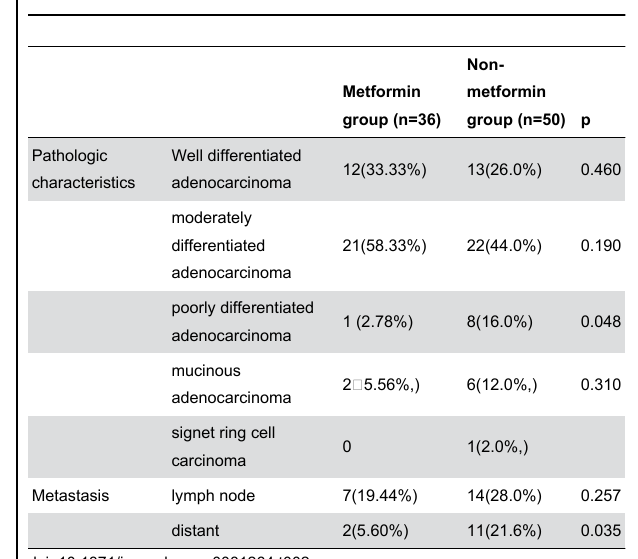
Table 2. Pathologic characteristics and metastasis in two groups.